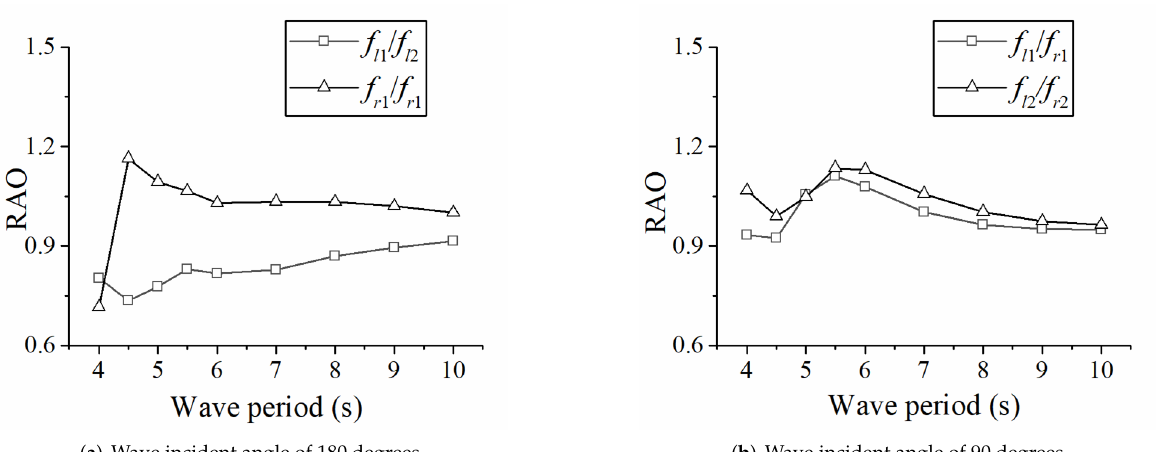
Figure 8. Heave motion response of floaters in different wave periods (two floaters on one side).